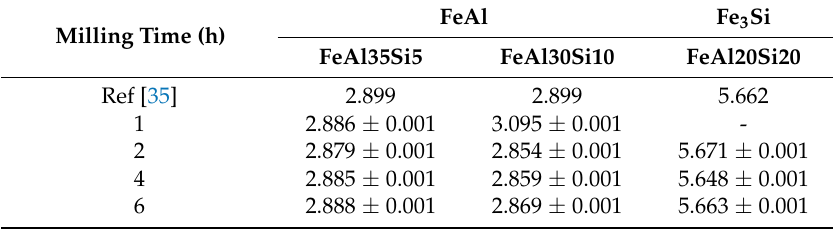
3 Si phases vs. milling